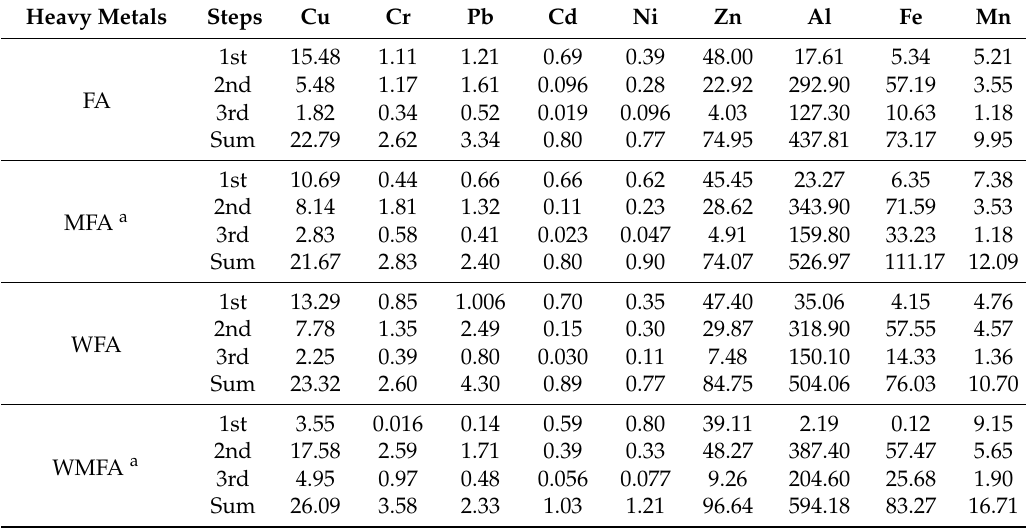
Table 5. Sequential extraction test